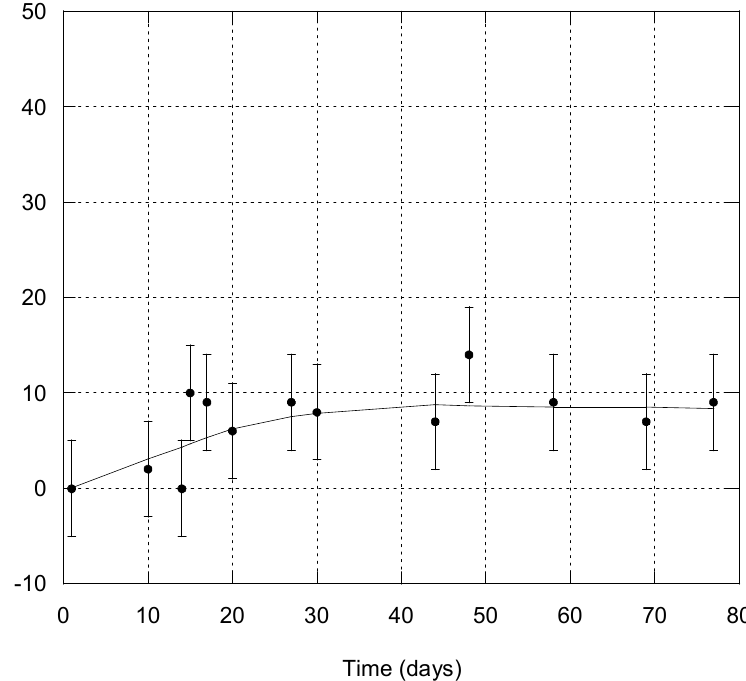
Figure 5. Kinetics of ε Vin release from onion-type MLLs. The error bar is deduced from three different measurements.